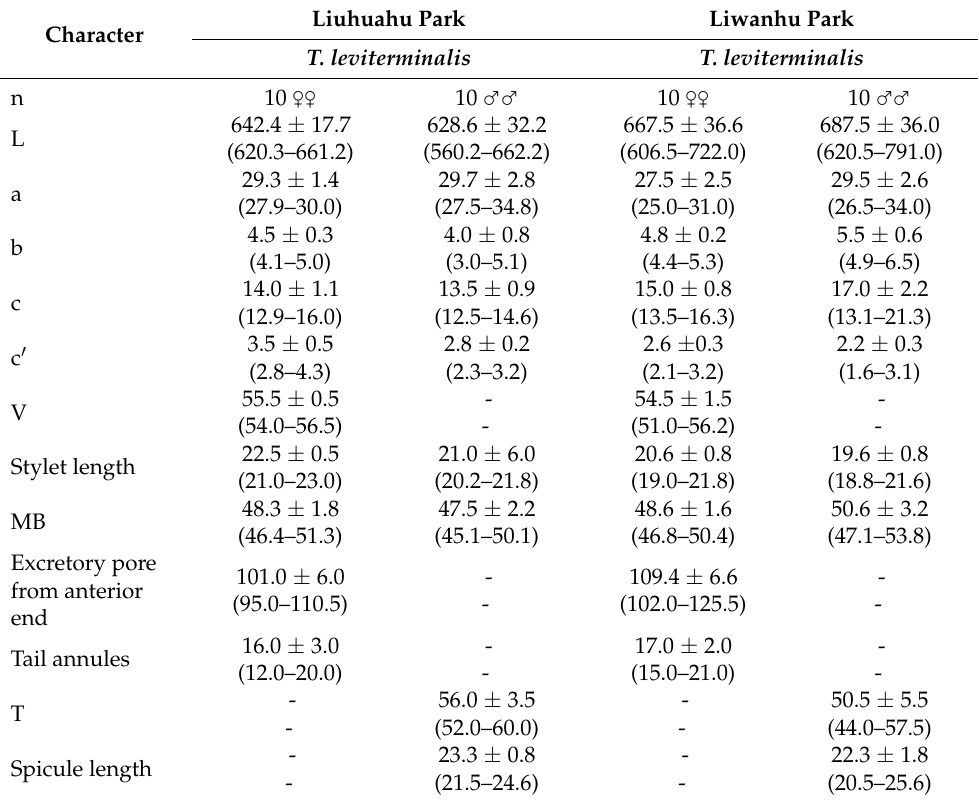
Table 8. Morphometrics of Tylenchorynchus leviterminalis populations mounted in formalin–glycerin. All measurements in µ m and in the format: mean ± s.d.